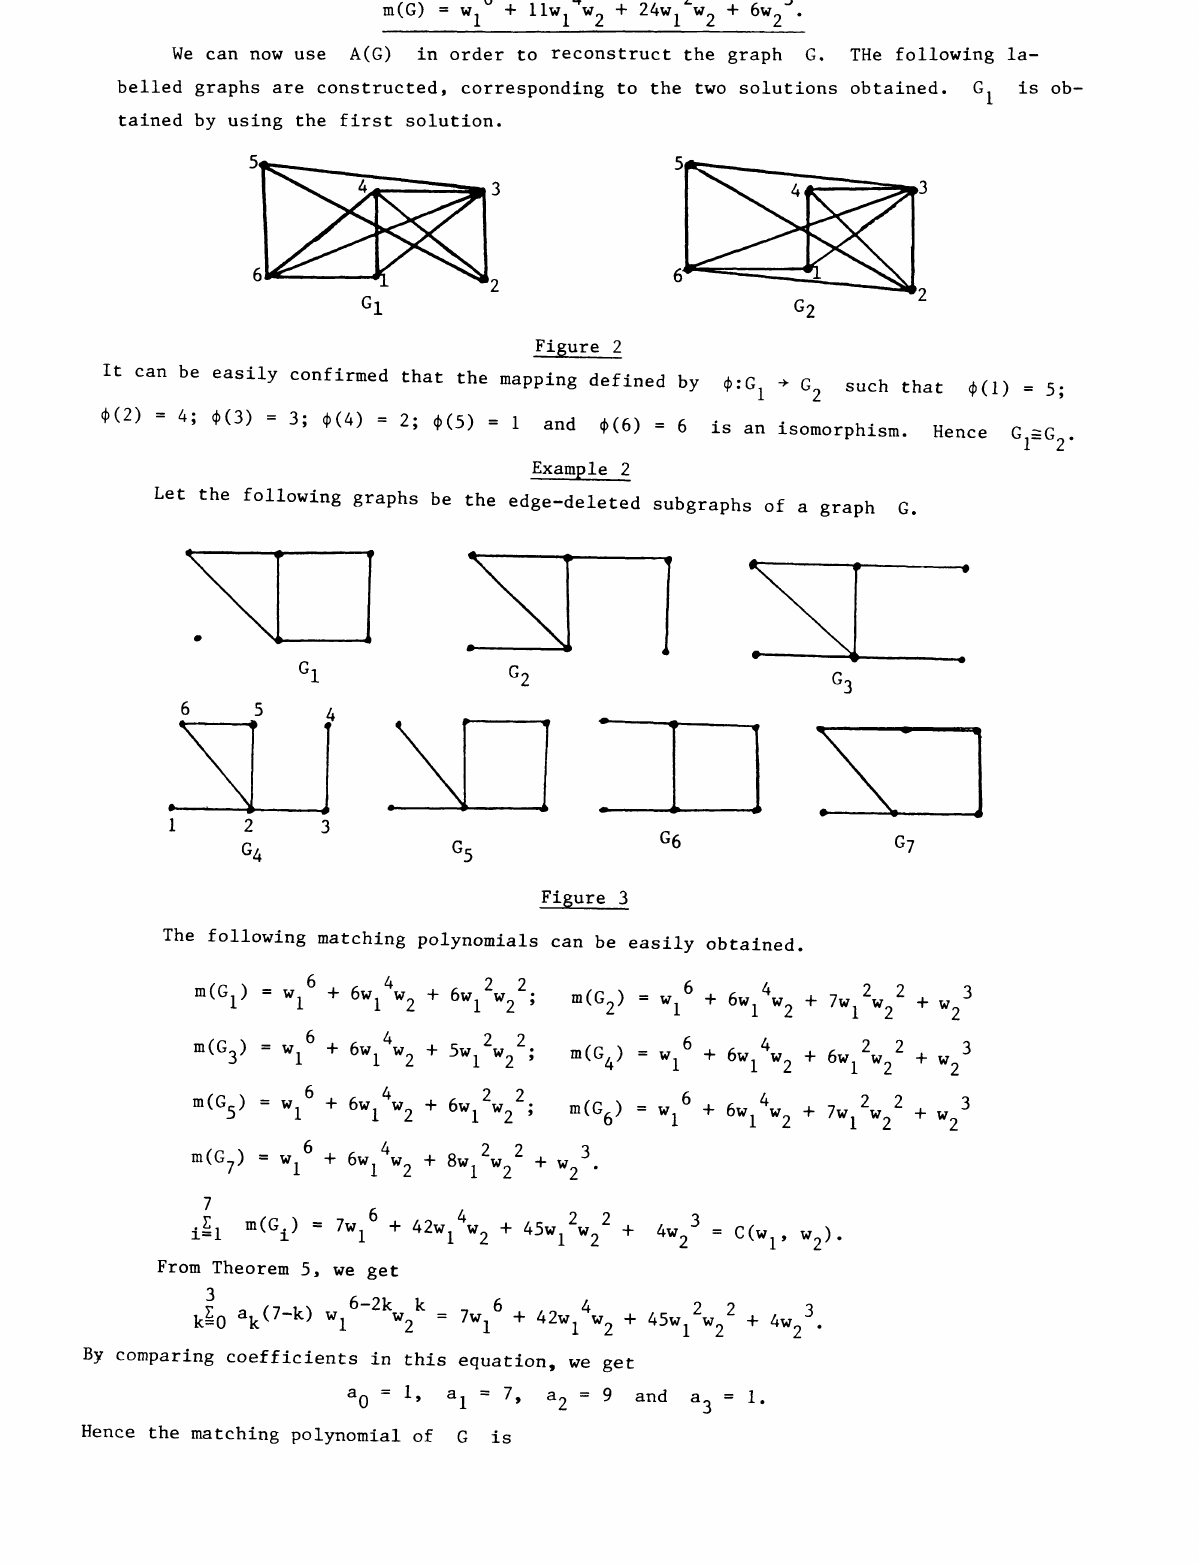
It can be easily confirmed that the